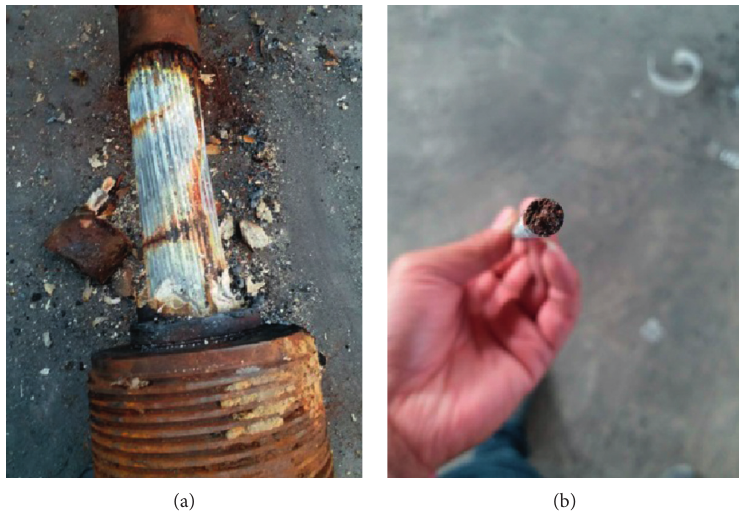
Figure 5: Serious corrosion of steel wires in the lower anchorage area.